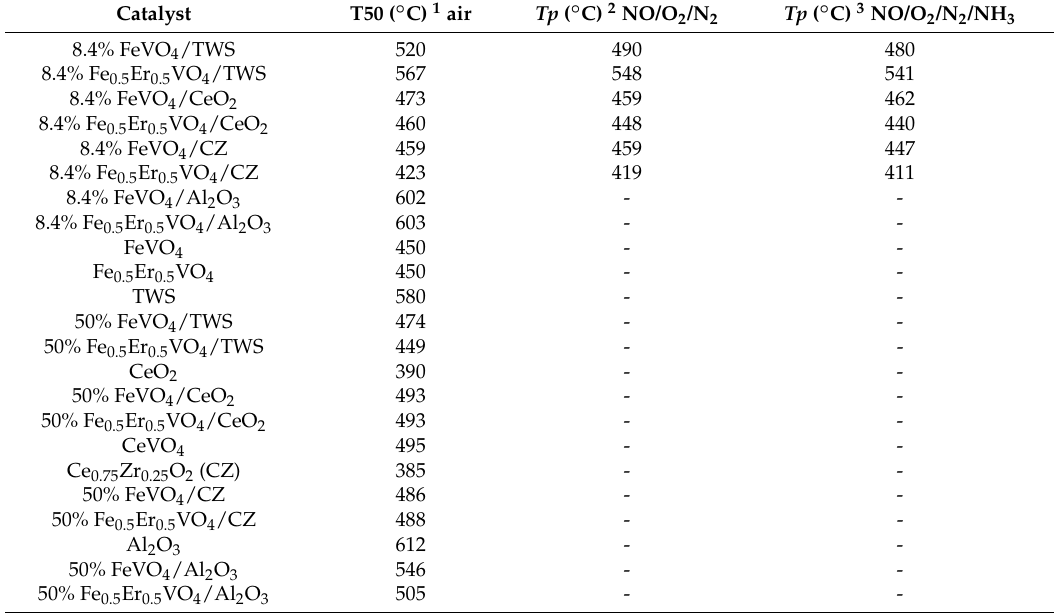
Table 2. Soot oxidation characteristic temperatures of investigated catalysts.